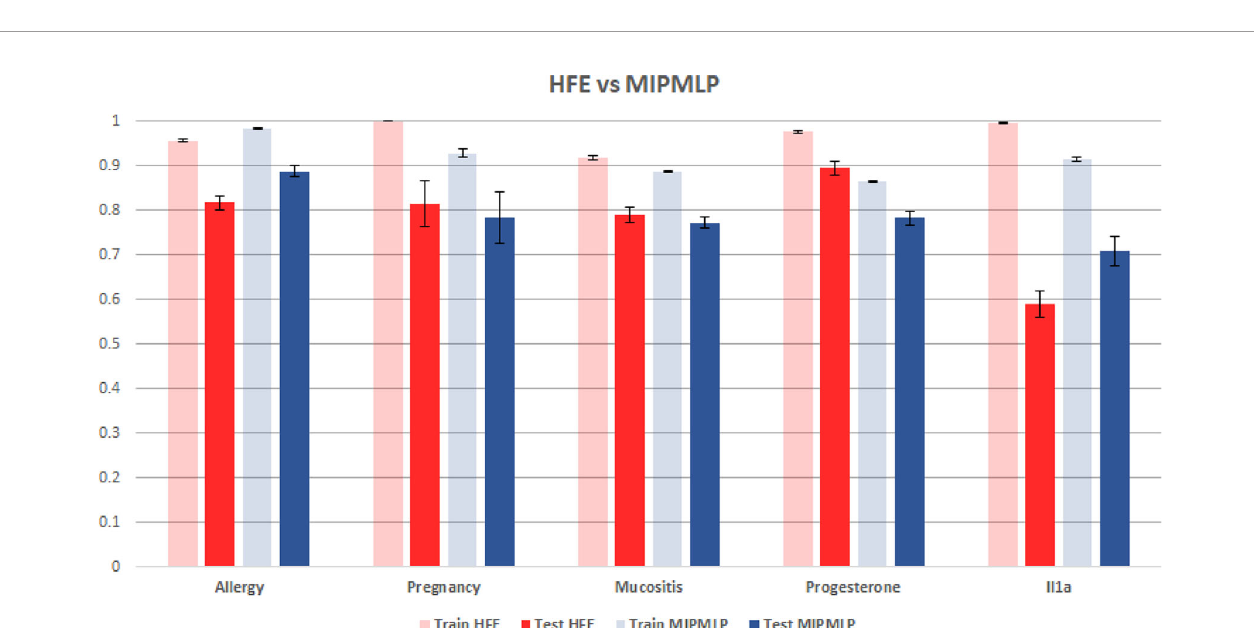
FIGURE 6 | HFE and MIPMLP mean AUC with standard errors bar. Shaded bars are training set and full bars are test set. Error bars are standard errors. The y axis is AUC. Different groups of bars are different